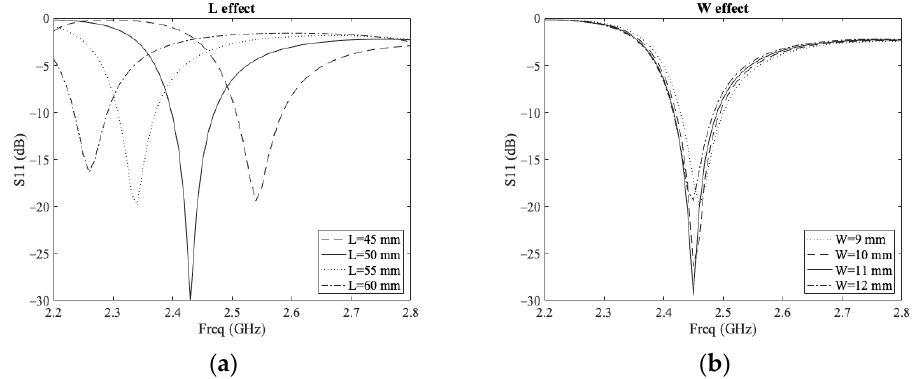
Figure 2. ( a ) Effect of different slot lengths on the S11 parameter ( L ); ( b ) Effect on different slot widths (W) on the S11 parameter.